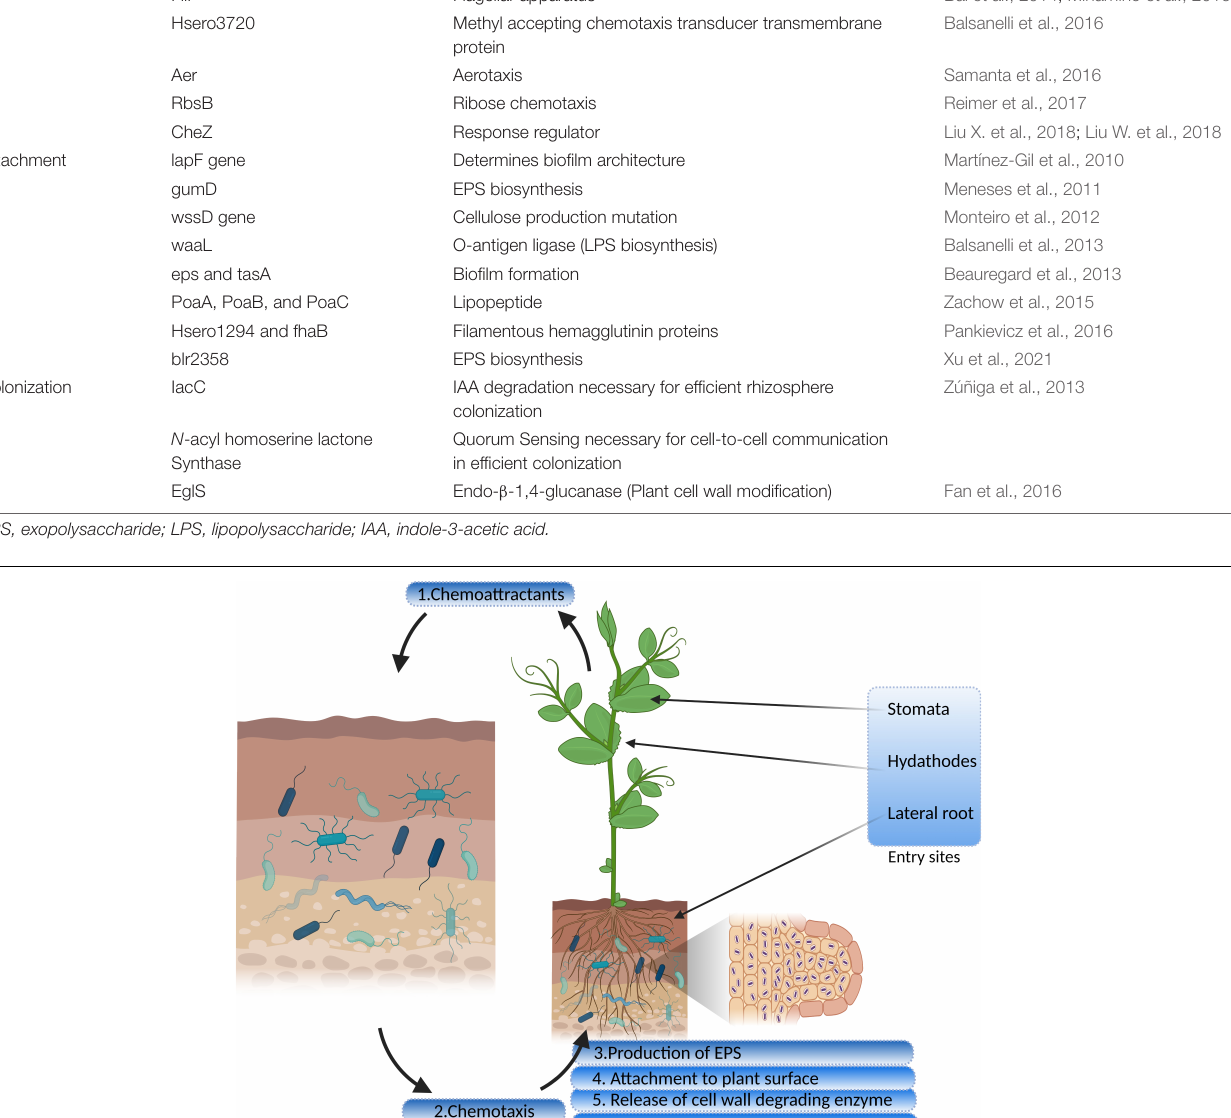
concentrations of free radicals. Colonization was found to